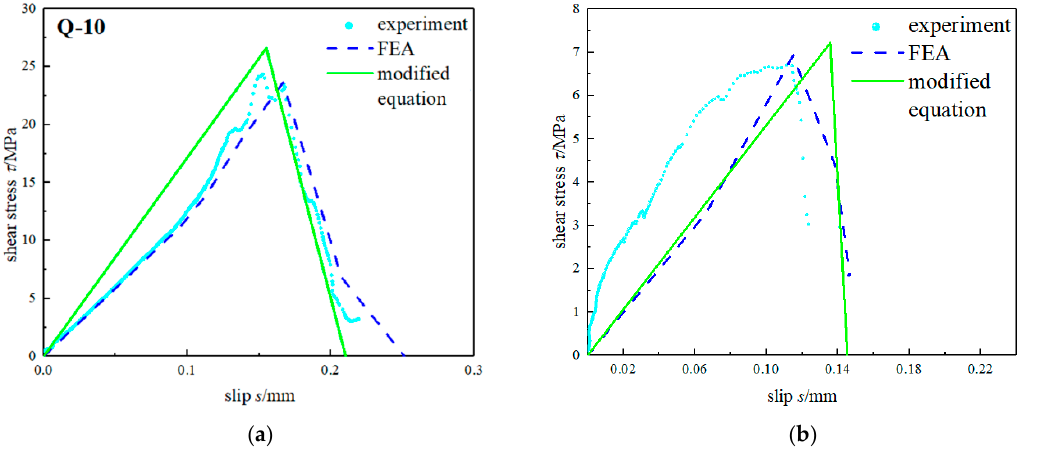
Figure 8. Comparison of Bond–Slip Curve between the Modified Equations, Verification Test, and FEA. ( a ) Q-01; ( b ) X-10. FEA. ( a ) Q-01; ( b )